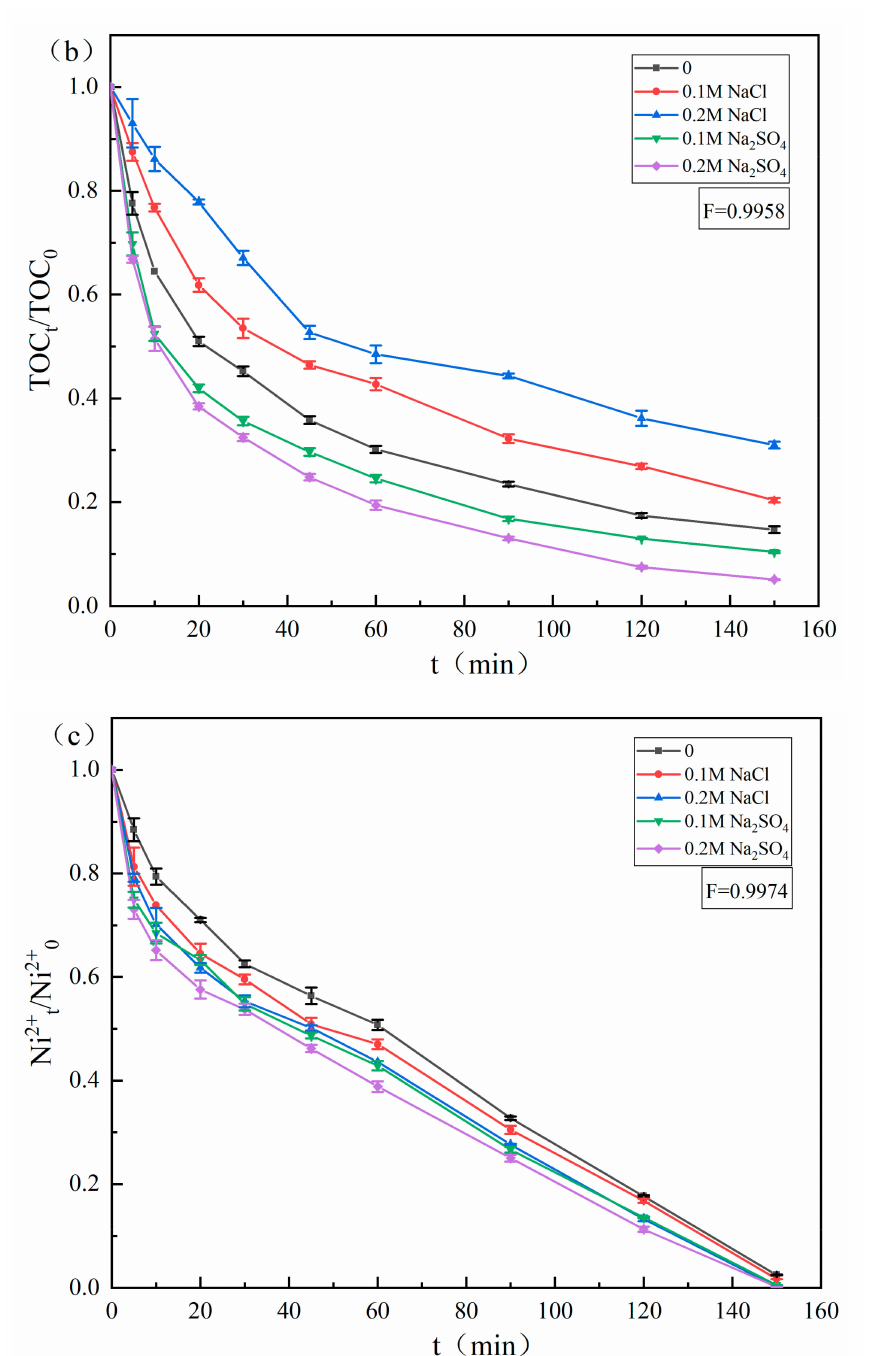
Figure 3. Evolution of COD Cr ( a ), TOC ( b ), and Ni 2+ ( c ) as a function of time in different supporting media. Electrolysis conditions: electroplating sludge leaching solution (180 mL), current density 50 A/m 2 , temperature 25 ◦ C, and pH